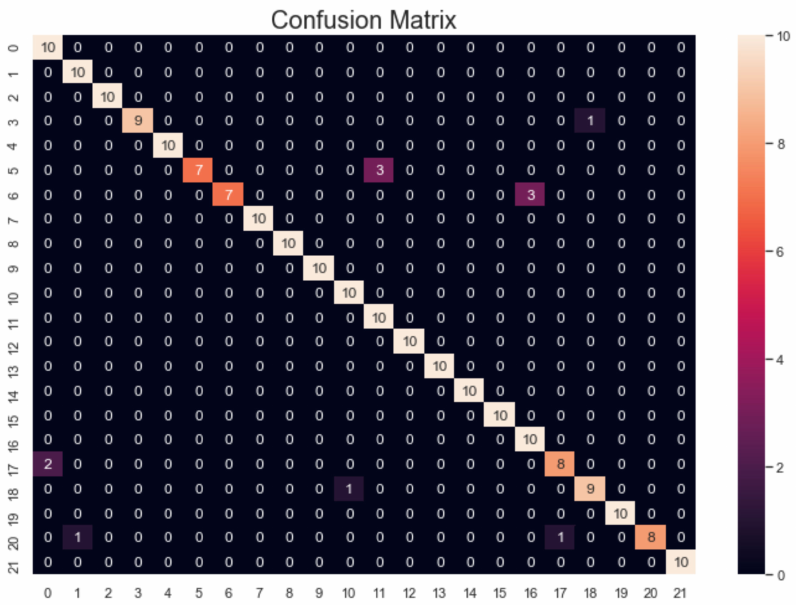
Figure 14. The confusion matrix of recognition result using the AlexNet model on the test im- age dataset.